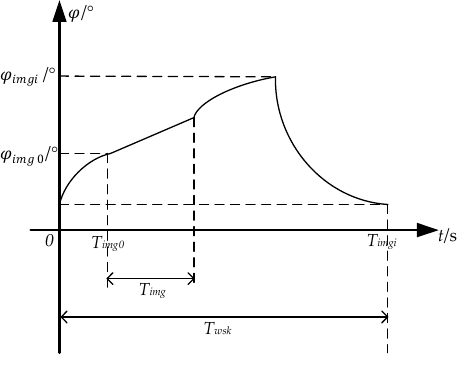
Figure 3. The whiskbroom angle curve in a scanning cycle.